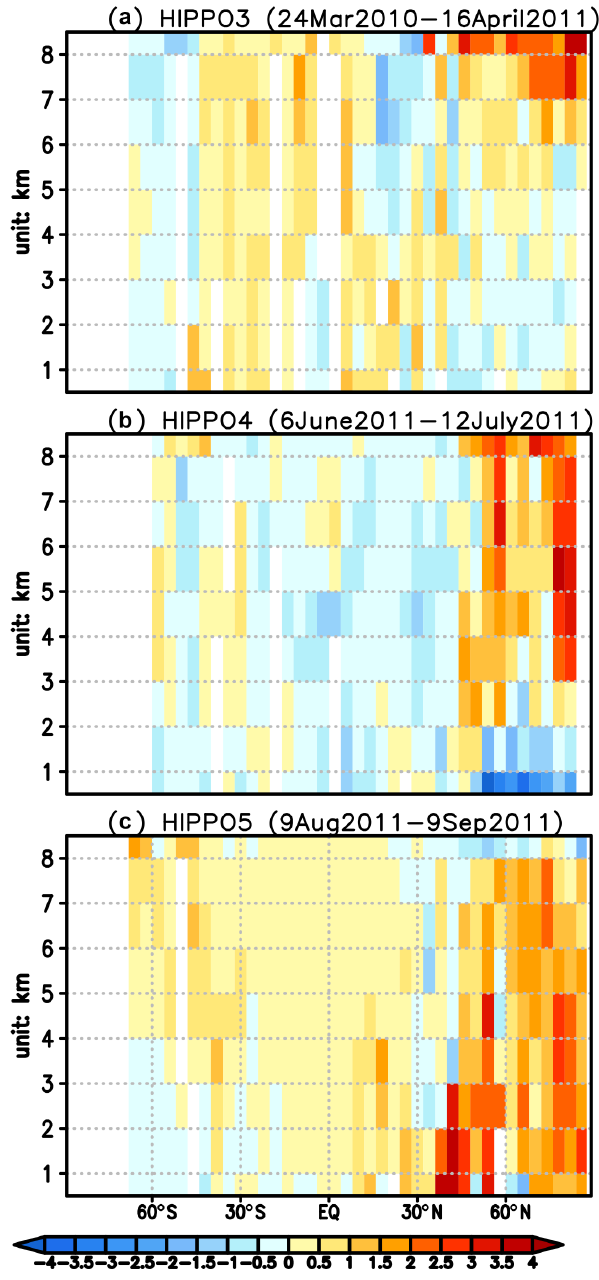
Figure B7. Differences between posterior CO 2 and HIPPO 3–5 aircraft CO 2 observations over the Pacific (A–C) as a function of latitude and altitude. Unit: